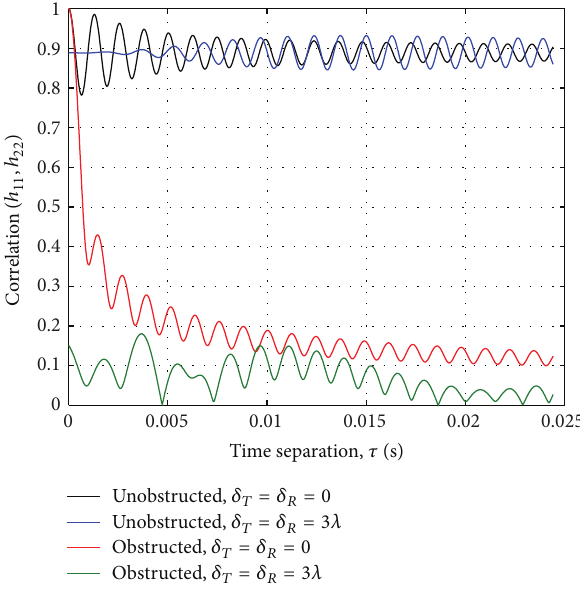
Figure 12: Time CFs for SISO (𝛿 𝑇 = 𝛿 𝑅 = 0) and MIMO (𝛿 𝑇 = 𝛿 𝑅 = 3𝜆) cases in the obstructed and unobstructed segments.